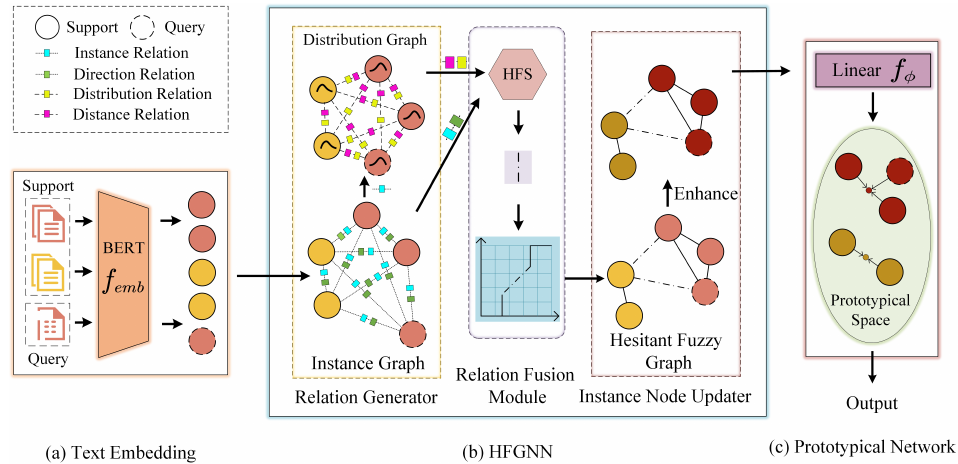
Figure 1. The overall framework of HFGNN-Proto. An example of a 2-way 2-shot task is illustrated. Different colored circles represent different classes. Circles with special symbols represent distribution features, and those without symbols represent instance features. Solid circles represent support samples, and dashed circles represent query samples. ( a ) the process of feature extraction; ( b ) The HFGNN component discovers, transmits, and integrates multi-attribute relations between samples to enhance embedding features. Note that the HFGNN contains several layers. For simplicity, only one layer is shown in the figure. The detailed process of this framework is described in Section 4.3. ( c ) The prototypical network component takes the augmented features as input and classifies query